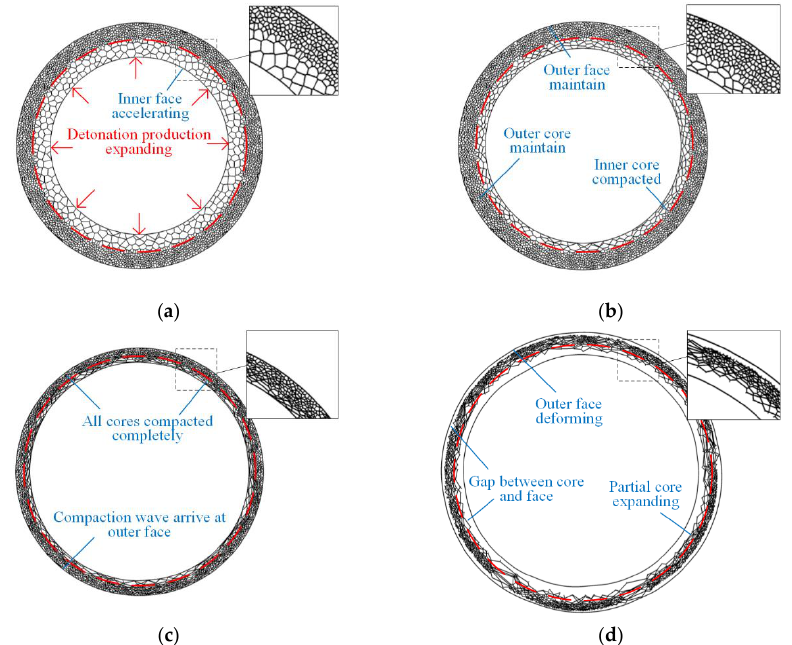
Figure 13. FE results of sandwich rings with positive gradient core. ( a ) First phase, ( b ) second phase compaction wave, ( c ) second phase outer core compacted, and ( d ) third phase.